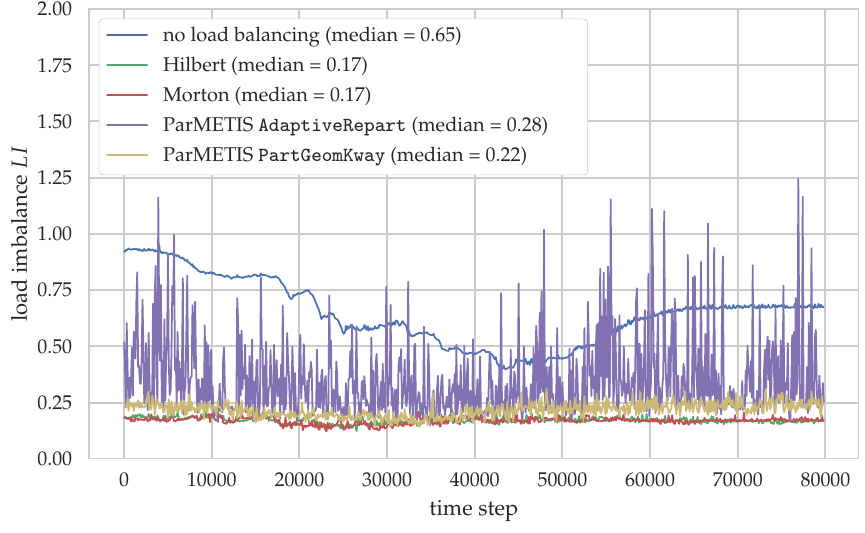
Figure 11. Load imbalance over the time steps for simulation shown in Figure